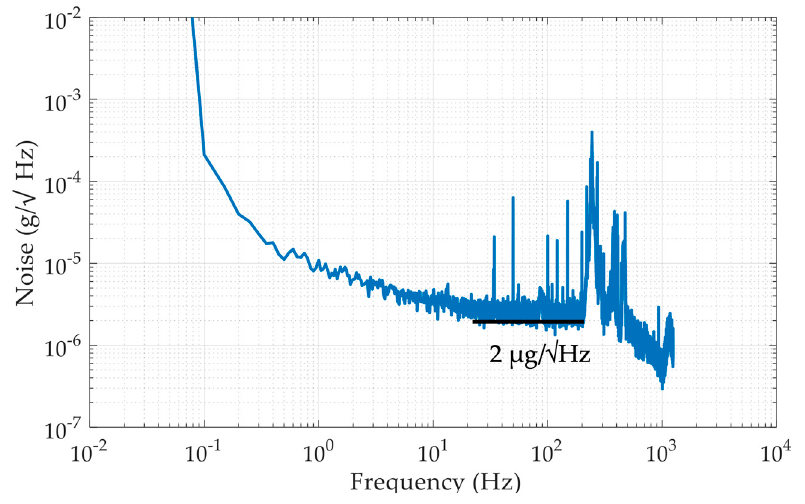
Figure 13. Results of the noise floor evaluation experiment.